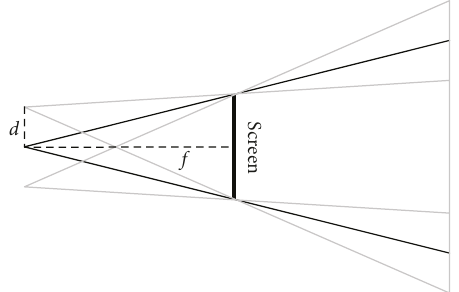
Figure 5: The frustums resulting from three di ff erent view